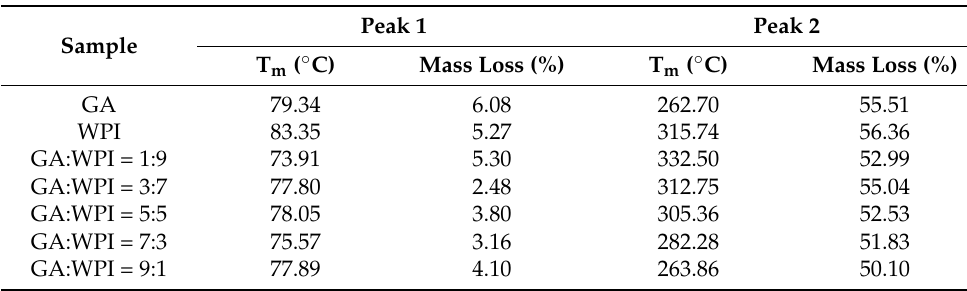
Table 4. The maximum weight loss temperature (T m ) and mass loss (%) of GA, WPI and microcapsules are covered with different ratios of GA:WPI.